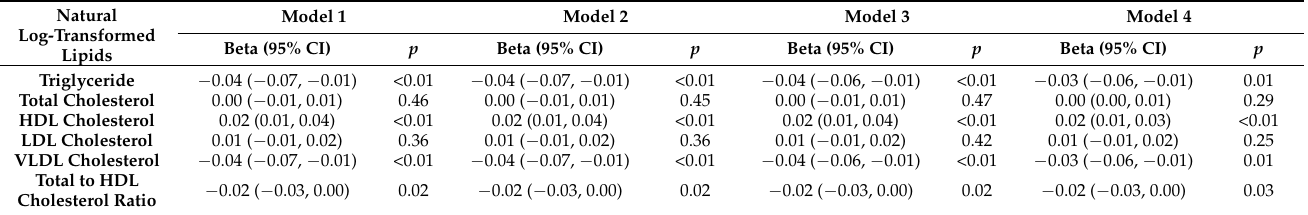
Table 3. Regression coefficients (95% confidence interval) for the association of each month increase in breastfeeding duration with natural log-transformed lipids at 12-months